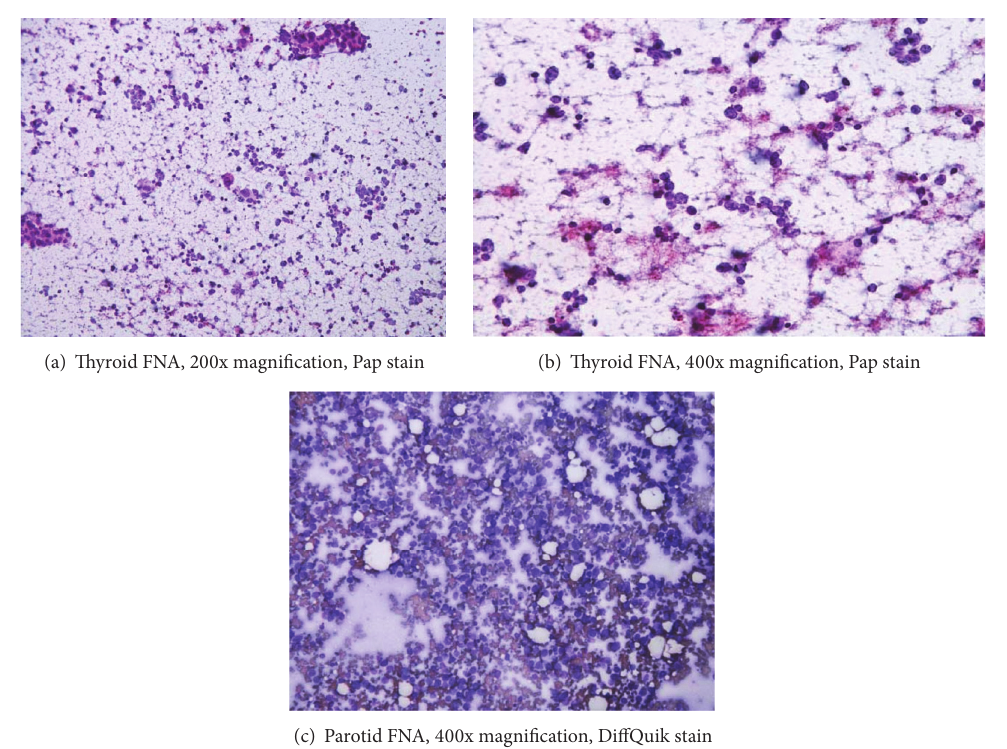
Figure 2: FNA of thyroid and parotid contained similar cytologic material with malignant cells arranged singly and in dyshesive groups in a necrotic background. A few background Hurthle cells are noted